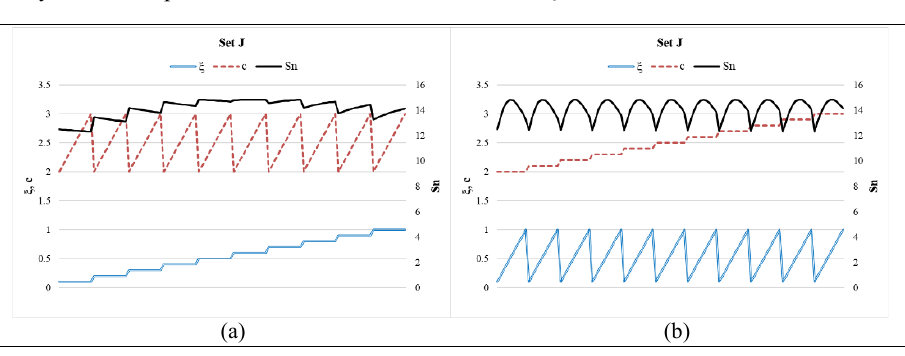
Fig. 1. The wealth 𝑆 2500 obtained by running the universal portfolio (13) on the data set J for 0.1 ≤ 𝜉 ≤ 1 and 2 ≤ 𝑐 ≤ 3 . The series 𝜉 and 𝑐 are plotted on the primary axis while series 𝑆 𝑛 is plotted on the secondary